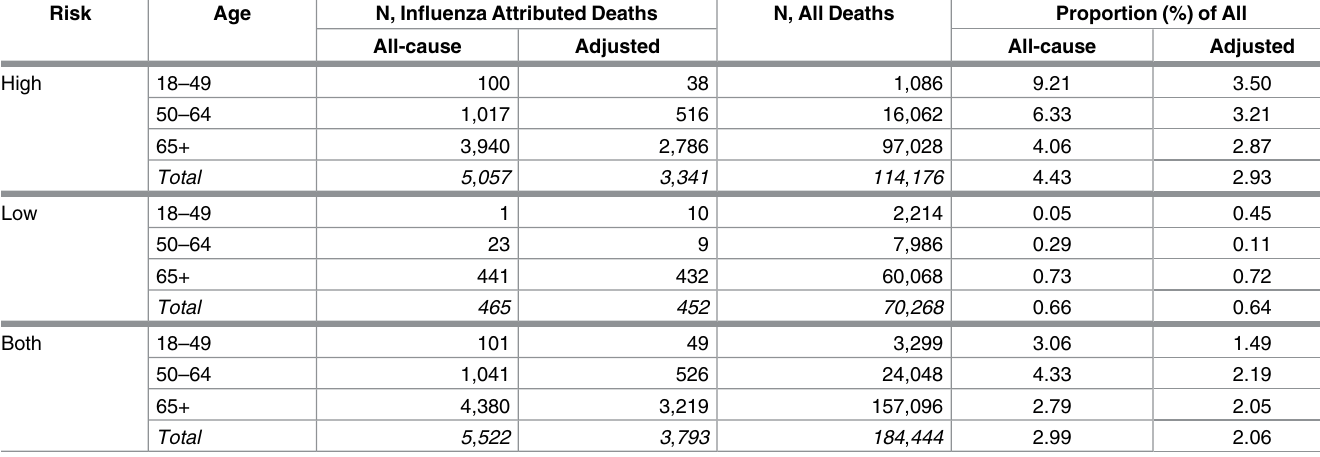
Table 5. Annual estimates of influenza-attributed all-cause mortality and influenza-attributed mortality adjusted for respiratoryor circulatory cause of death as the proportion of all deaths by risk and age group averagedover five respiratory seasons. Risk Age N, Influenza Attributed